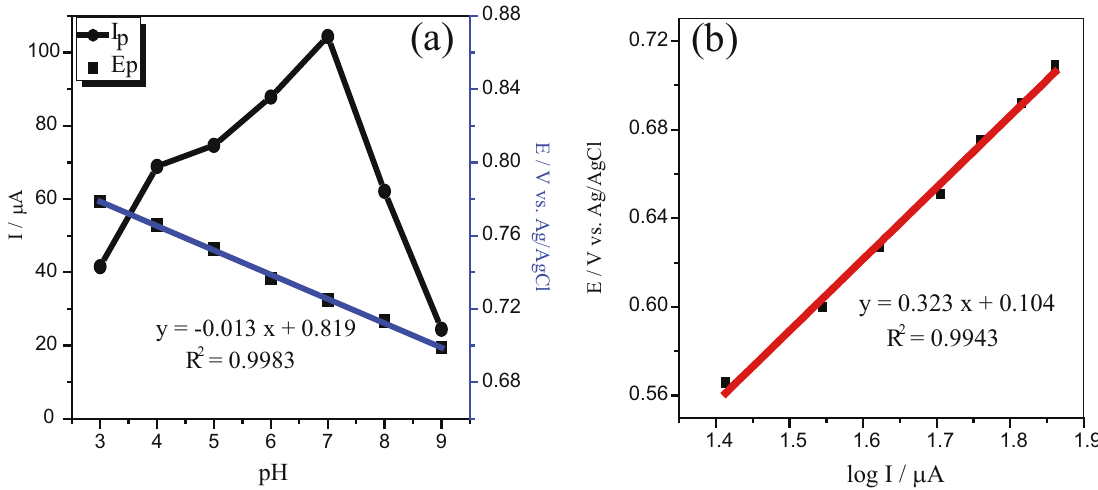
Figure 6: ( a ) Plot of I p and E p versus pH = 3.0 – 9.0 for 0.5 mM NPX in 0.1 M PBS at the poly ( r - o - NBA ) /GQDs/CPE at a scan rate of 100 mV · s − 1 ; ( b ) Tafel curve.